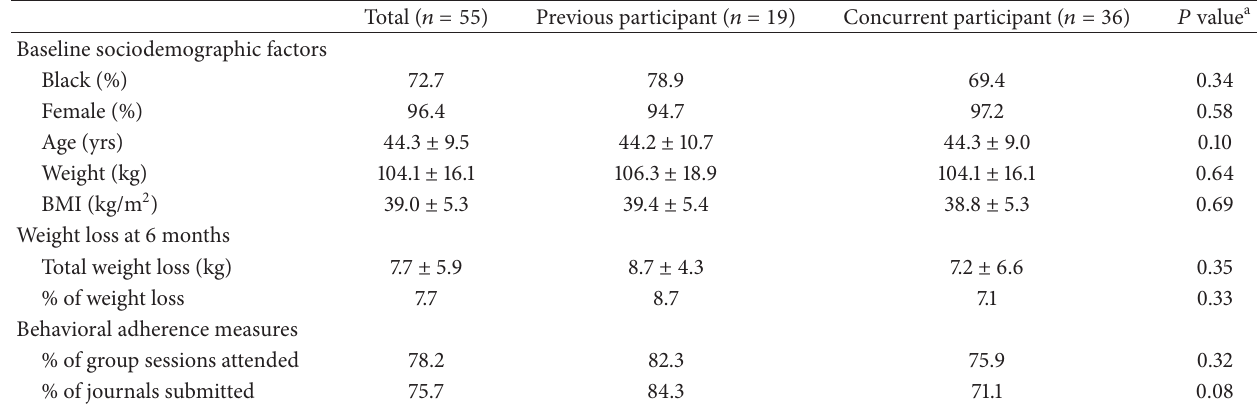
Table 2: Sociodemographic characteristics of individual social contacts ( 𝑛 = 55 ).